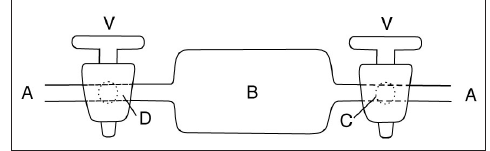
Fig. 4. Sample glass bottle. A – outlet tube; B – chamber; C – piston hole; D – piston tube; V –